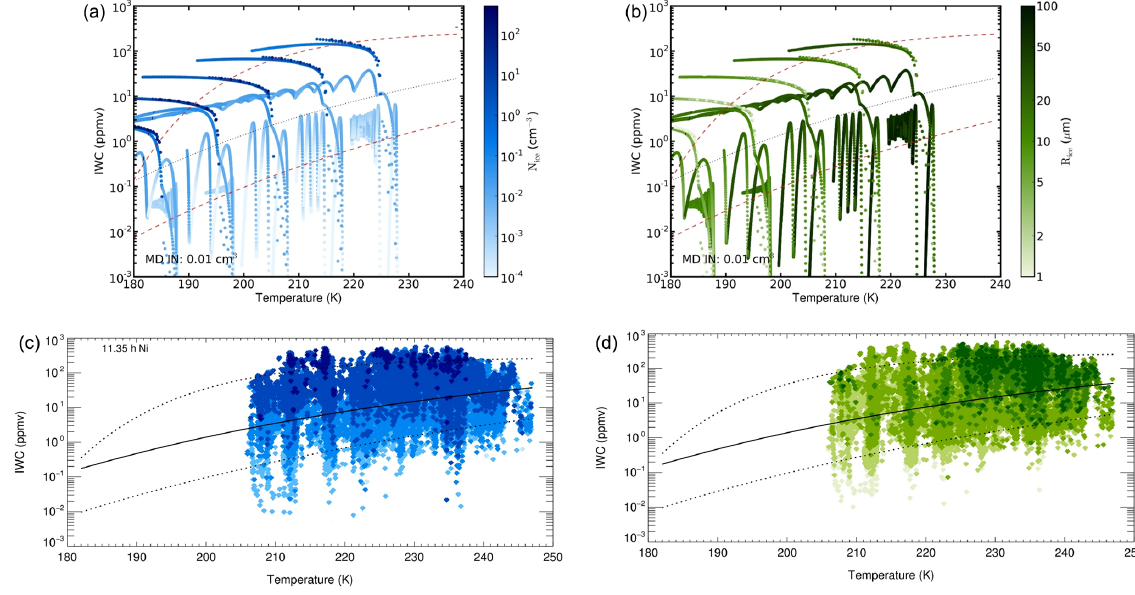
Figure 10. IWC colored by N ice (left) and R ice (right); (a, b) MAID scenario HET + HOM | 0 . 01 − MD